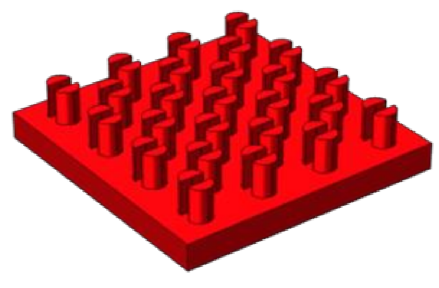
Figure 3. Geometric model of hotspot area.